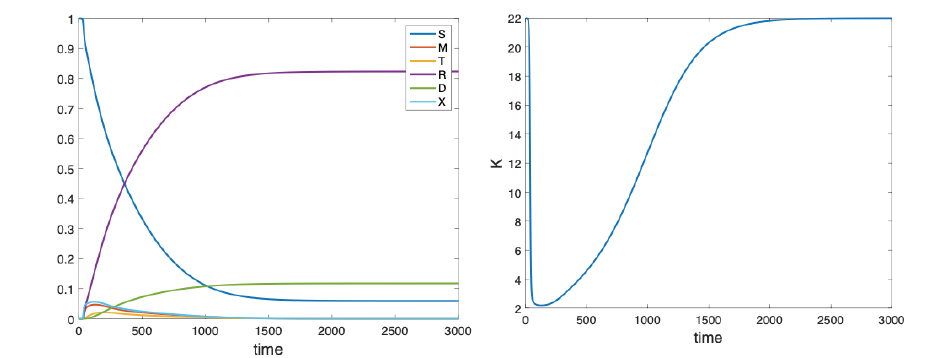
Figure 8. SEIR model with risk perception, 𝑐 = 100 , other parameters as in Fig 7. Left: time plot of observables Eq. (2), right: time plot of connectivity 𝐾(𝑡) , Eq. (3)